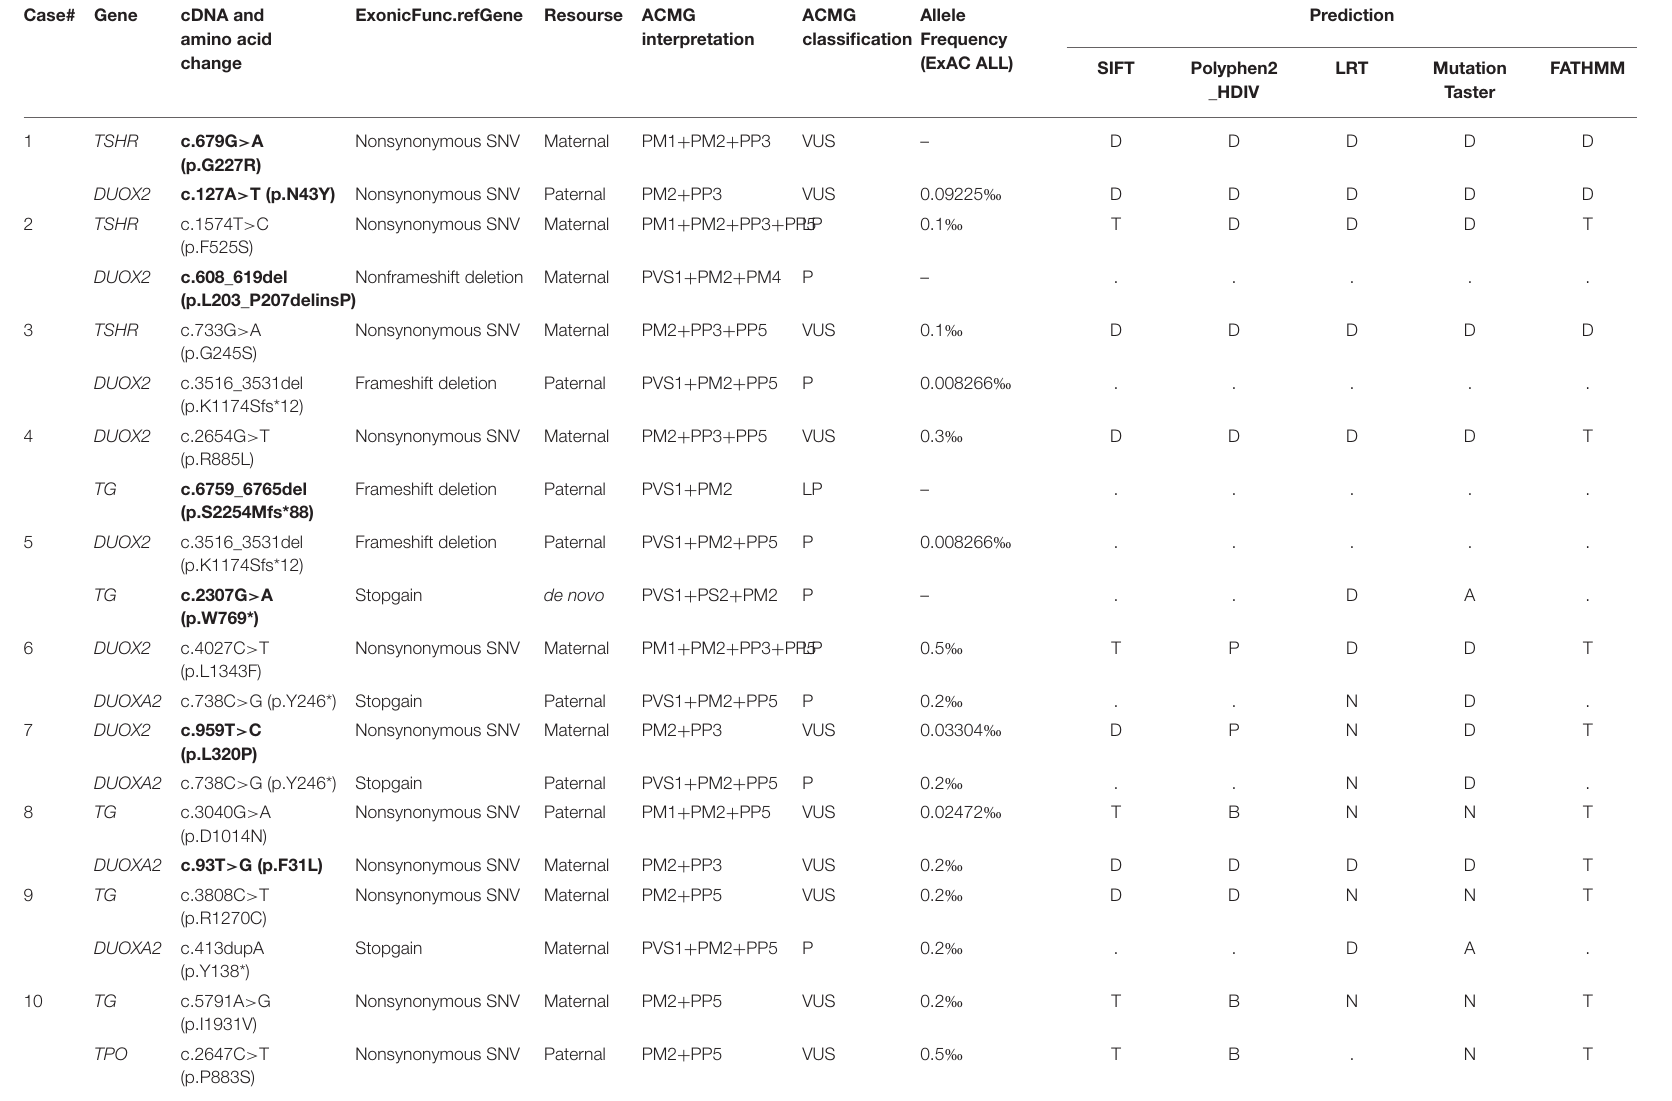
TABLE 2 | Genetic variants and their prediction on protein function. Case#